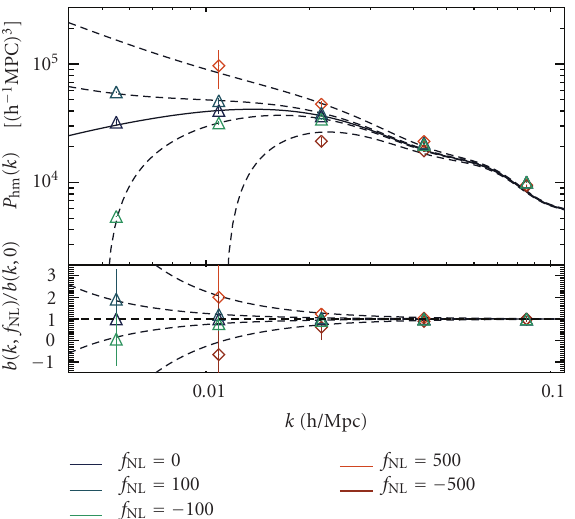
Figure 20: Matter-halo cross-power spectrum measured in simula- tions with local non-Gaussian initial conditions for di ff erent values of f NL , from the study by Dalal et al. in